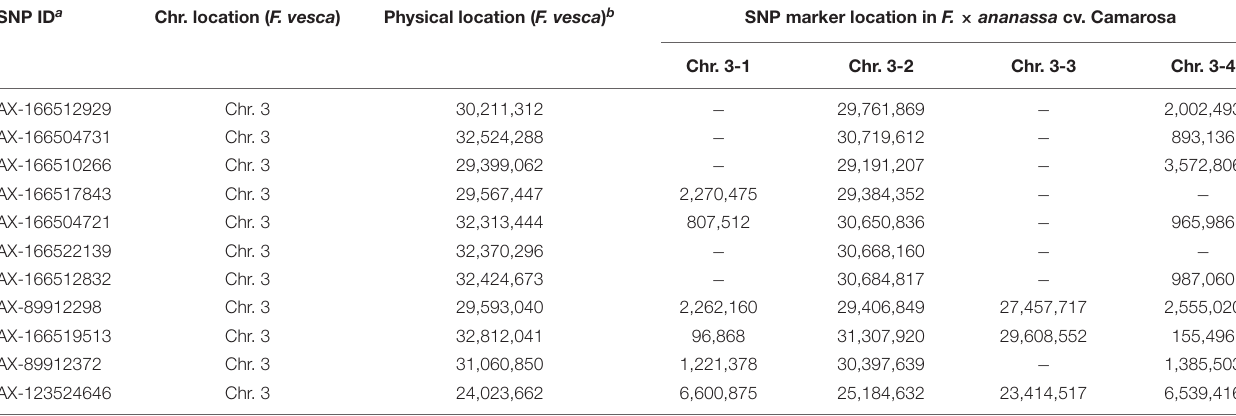
TABLE 1 | Physical location of the FaFAD1 locus in diploid ( F. vesca ) and octoploid ( F. × ananassa ) strawberry. SNP ID a Chr. location ( F. vesca ) Physical location ( F. vesca ) b